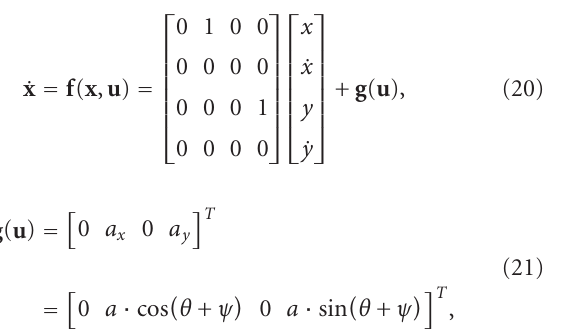
accuracy of the position sensor is given as 1.0 degrees for bearing and 0.005 m for